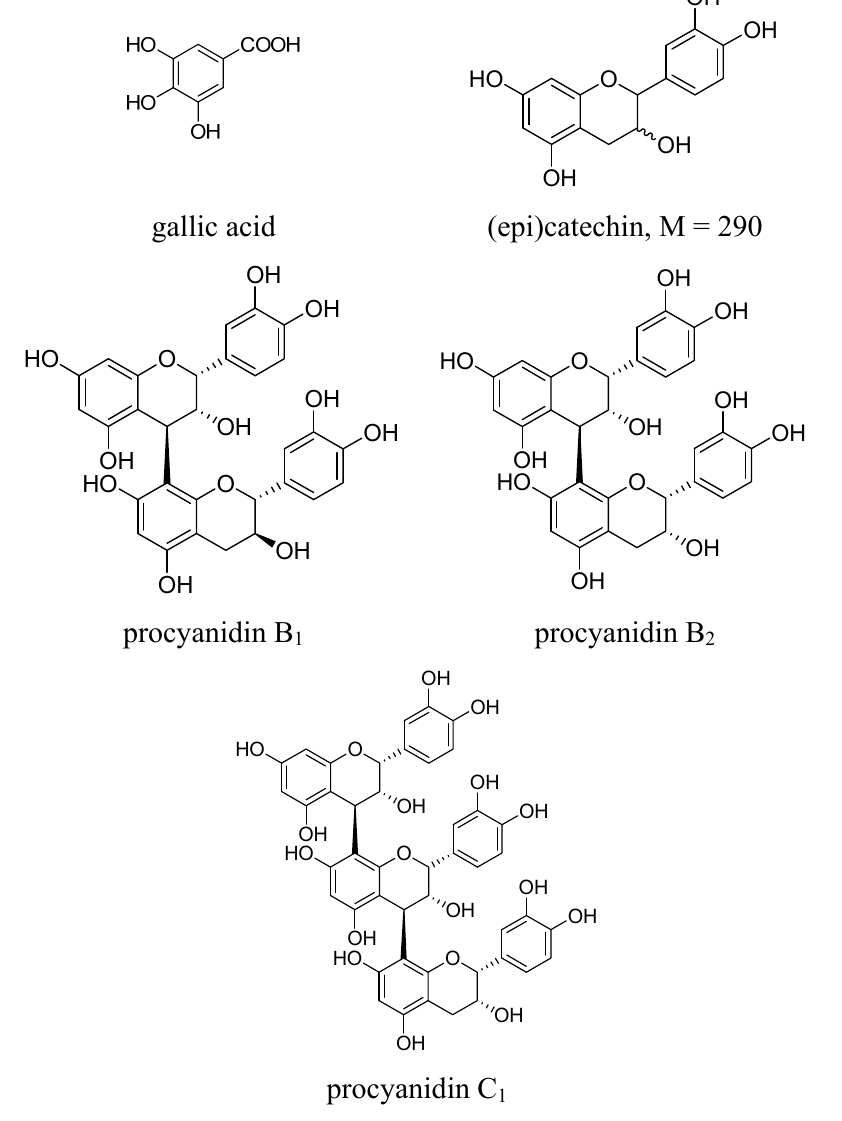
Figure 2. Chemical structures of the identified compounds in extract of Spatholobus suberectus.